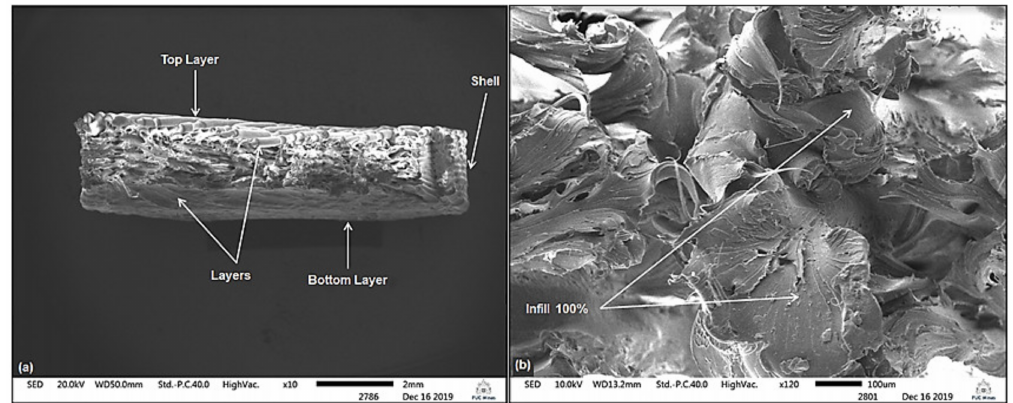
Figure 16. Microstructure images for 100% sample infill: ( a ) the deposition lines of the layers, shell, and top / bottom layer and ( b ) the internal reticulations.